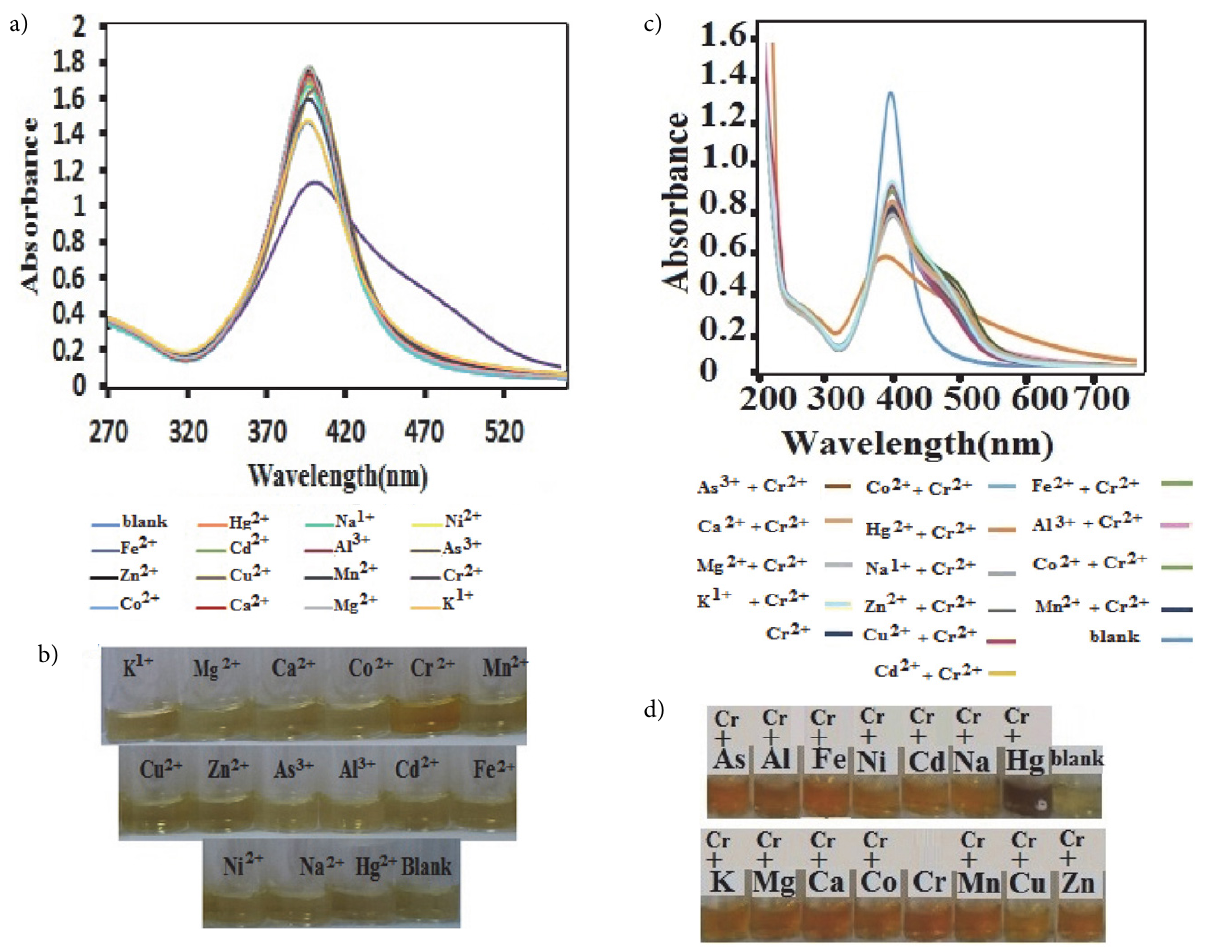
Figure 6. Selectivity of the SDS-CD-AgNPs for Cr 2+ compared with other ions: (a) UV-vis spectra; (b) photographic images of detecting SDS-CD- AgNPs incubated with K + (5 µM), Cu 2+ (5 µM), Hg 2+ (5 µM), or other ions (5 µM) at pH 7; (c) UV-vis spectra; and (d) Photographic image of de- tecting SDS-CD-AgNPs incubated with the mixture of Cr 2+ (5 µM) and other ions (5 µM) at pH